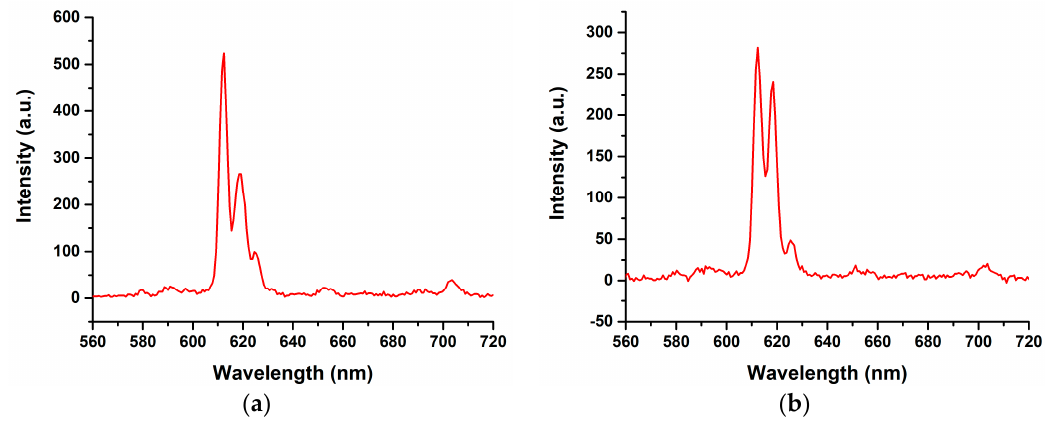
Figure 8. Triboluminescence spectra of ( a ) [Eu( pp -dbm-Cl 2 ) 3 phen] and ( b ) [Eu( mm -dbm-Cl 2 ) 3 phen].